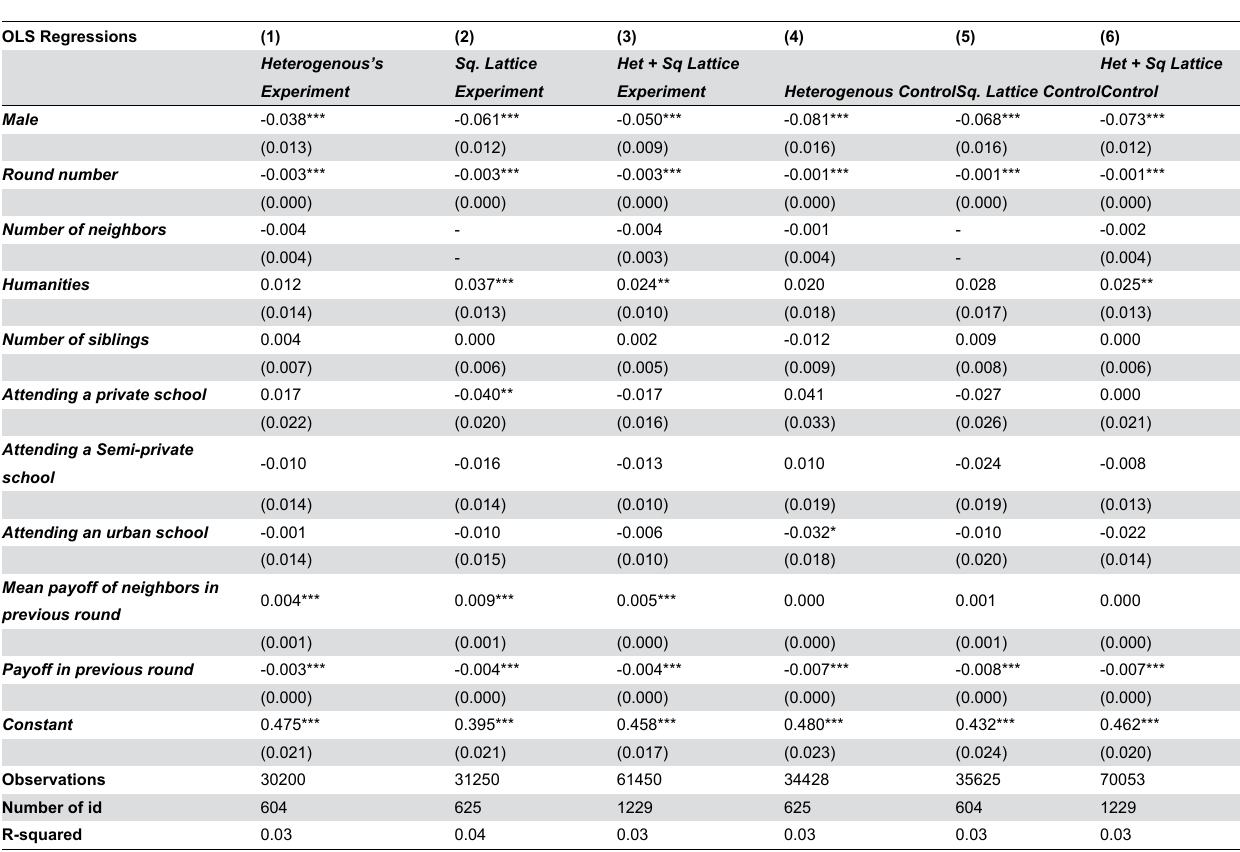
Table 2. OLS Regressions for cooperation of individuals playing the Prisoner’s